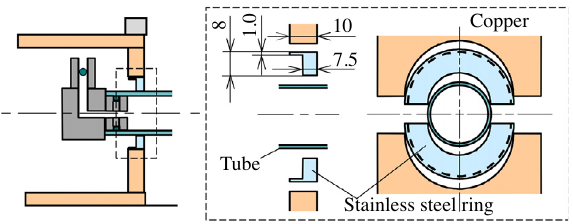
Figure 11. Stainless steel ring for prevention of decrease in temperature inserted between tube and electrode.